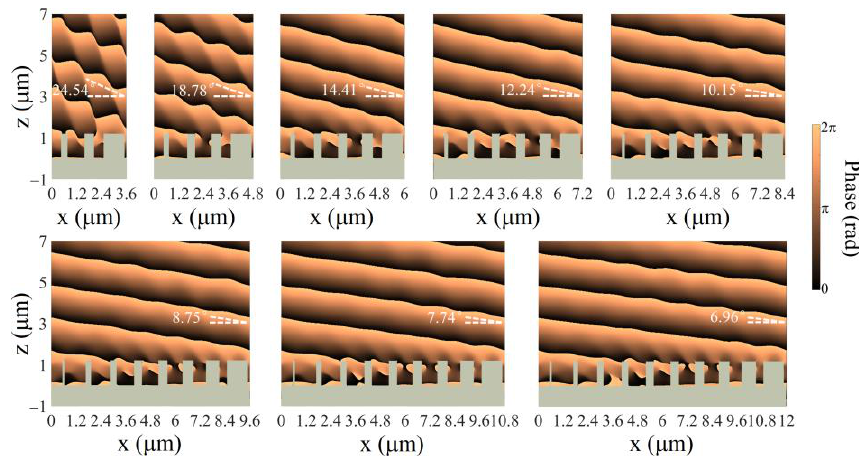
Figure 5. Simulated phase profiles of the deflected light beams through monolithic metasurface deflectors with varied numbers of LN nanopillars in one supercell.